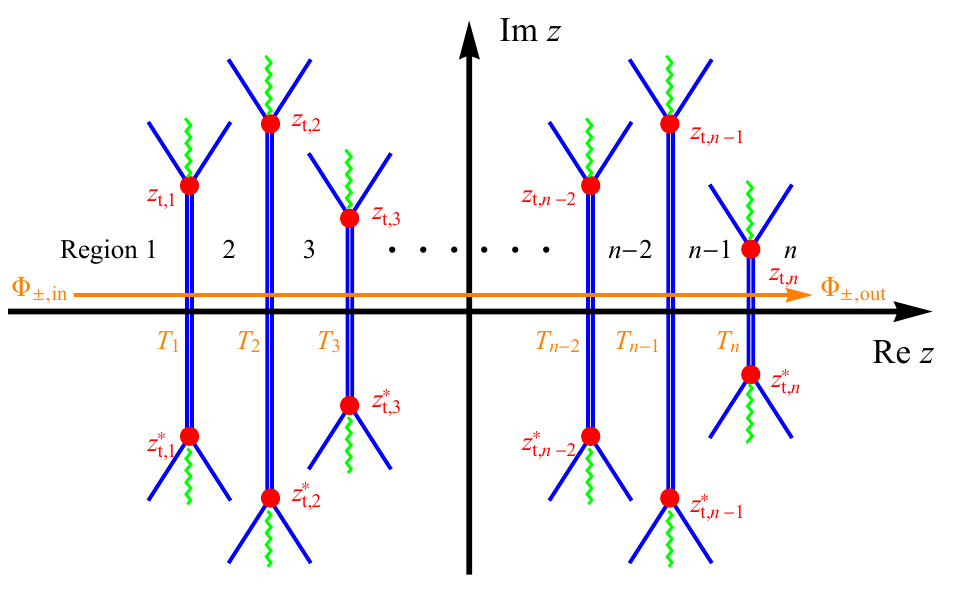
Figure 1 . (color online) Generic structure of a Stokes graph for the potential Q (3.1). The red points, the blue lines, and the green wavy lines are representing turning points, Stokes lines, and branch cuts, respectively. Stokes segments connecting a pair of ( z t ,i , z ∗ ) are represented by the t ,i doubled blue lines. The orange arrow represents the path we consider to compute the Bogoliubov transformation between Φ ± , in and Φ ± , out . Note that the Stokes segments are depicted by straight lines. This is just for simplification, and a Stokes segment is not necessarily a straight line in general. Also, there could exist other Stokes segments connecting pairs on either half of the complex z -plane ( z t ,i , z t ,j ) or ( z ∗ , z ∗ ) . Those Stokes segments do not cross the real axis directly (see also footnote 3 t ,i t ,j for appearance of multiply degenerated Stokes lines) and thus are omitted here for